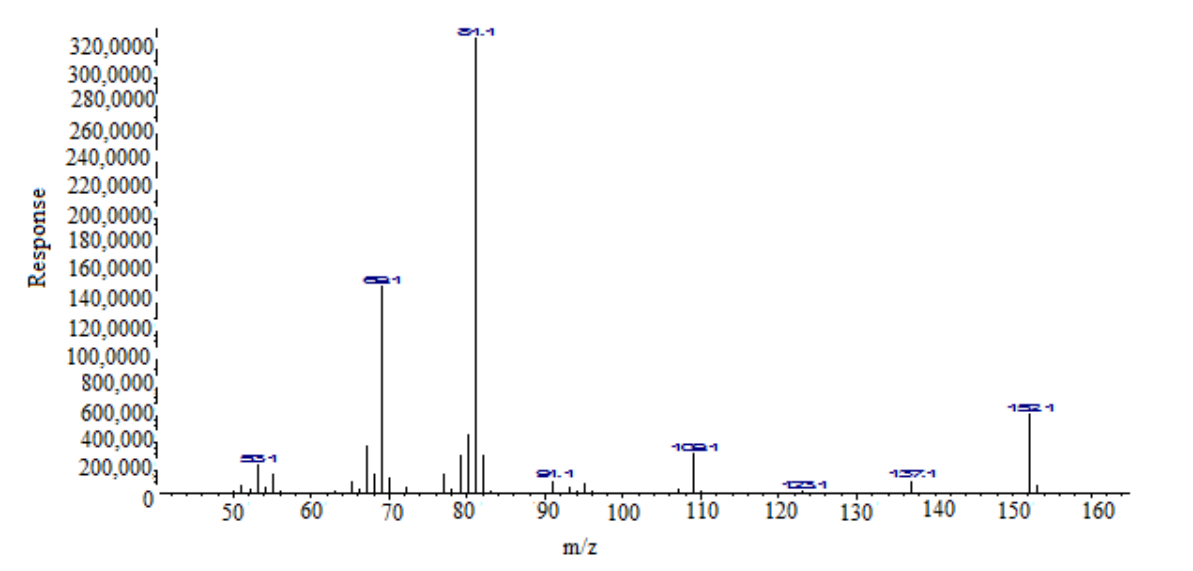
Figure 3. Mass spectra ( m / z ) of standard FCO.